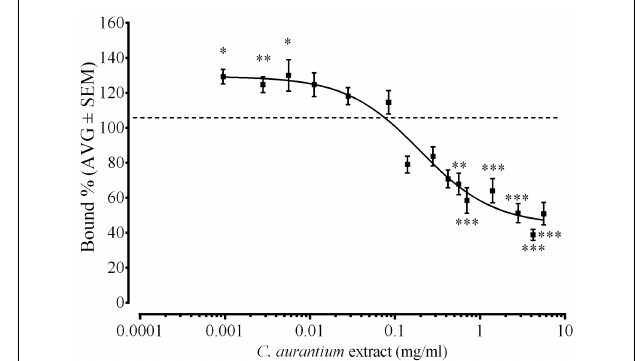
FIGURE 3 | Effect of C. aurantium extract on [ 3 H]Glu binding. Synaptic membranes were incubated with different concentrations of C. aurantium in the presence of 20nM [ 3 H]Glu. C. aurantium extract reduced [ 3 H]Glu binding at concentrations ranging from 0.42 to 5.60mg/mL and increased [ 3 H]Glu binding at concentrations ranging from 0.000952 to 0.0056mg/mL. Results are shown as percentage of total binding ± SEM of three experiments. ∗ vs. Total P < 0 . 05; ∗∗ P < 0 . 01; ∗∗∗ P < 0 .